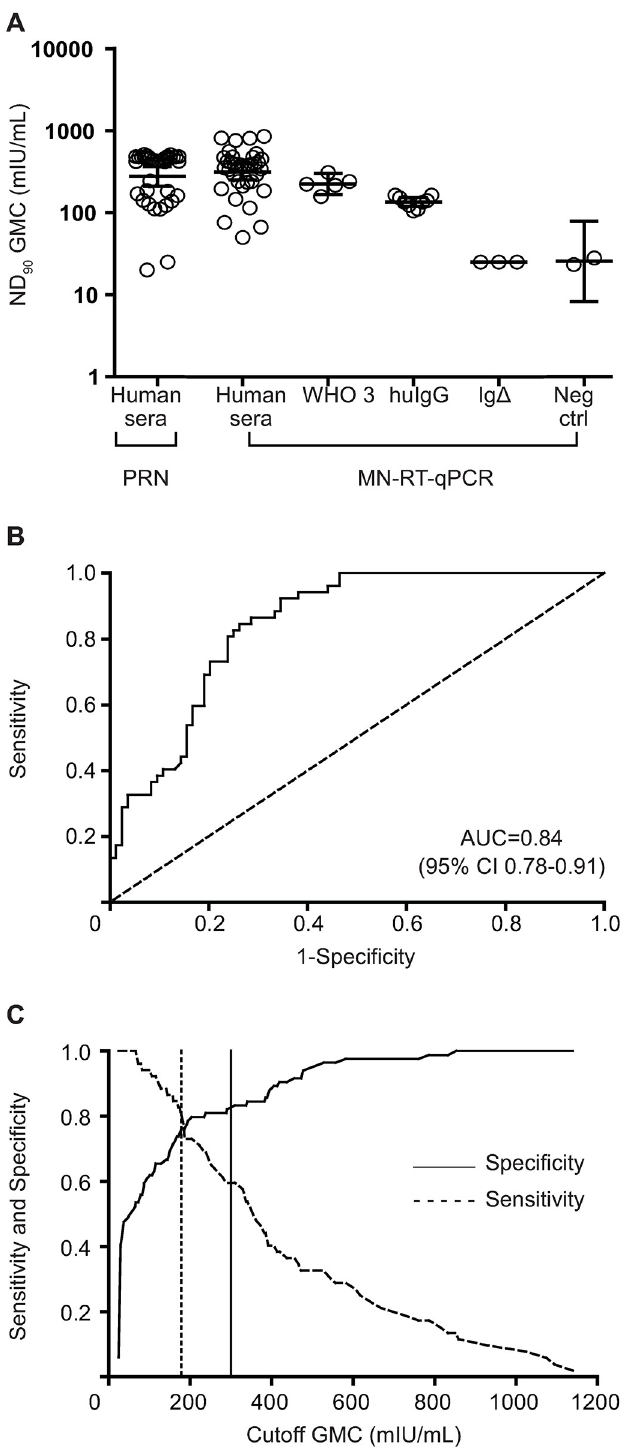
Fig 6. ROC analysis and estimation of concentration associated with protection in MN-RT-qPCR assay. (A) Plot of concentrations of human serum samples (N = 36) and control samples when tested in either PRN or MN-RT-PCR assays. The human serum samples were initially selected based on the ND 50 PRN results of 180–220 mIU/mL, representing protective concentrations. WHO 3 IS and huIgG (BEI NR #21793) were specifically diluted to have an expected concentration of ~200 mIU/mL. The bars represent the 95% CI from the GMC (solid line) for each group. (B)